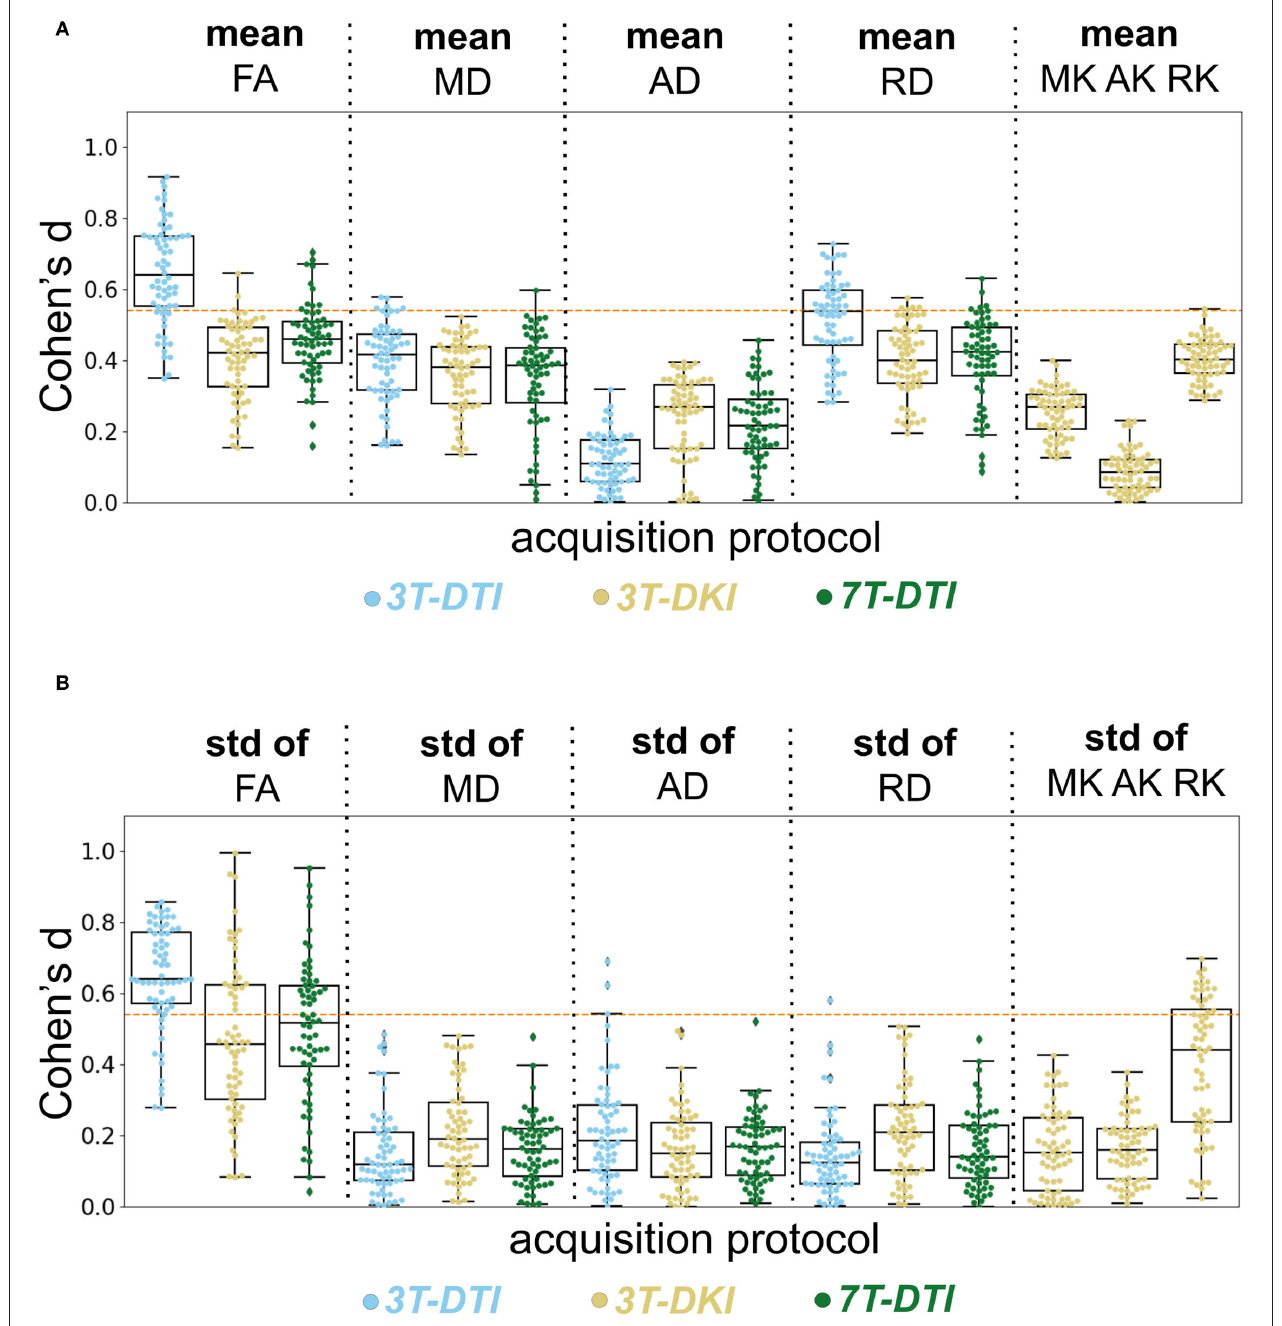
FIGURE 8 | Evaluation of the acquisition protocol on the effect size. Columns show different diffusion parameters obtained with different protocols 3T-DTI, 3T-DKI, or 7T-DTI, shown in cyan, gold, and green, respectively. The mean (A) and SD (B) of each diffusion parameter, derived for each protocol were examined. Pipeline VII was used in all cases. No smoothing was applied. The swarm and box plots show the distribution and quartiles (together with the median) of Cohen’s d values among tracts, respectively. Overall, 3T-DTI was the acquisition protocol that yielded the three most sensitive diffusion parameters [mean FA, SD of FA, and mean radial diffusivity (RD)], and exhibited effect sizes above 0.54 a threshold of significance before correcting for multiple comparisons) in the largest number of tracts. Moreover, the results between 3T-DTI and 7T-DTI were more similar than those between 3T-DTI and 3T-DKI, which implies that the choice of the diffusion protocol impacted the effect size analysis more than the choice of the magnetic field strength. Kurtosis parameters did not yield significant effect sizes, with the exception of the SD of RK, which had significant effects in a small number of tracts. An orange dotted line in each plot defines the threshold in effect size above which the result is considered